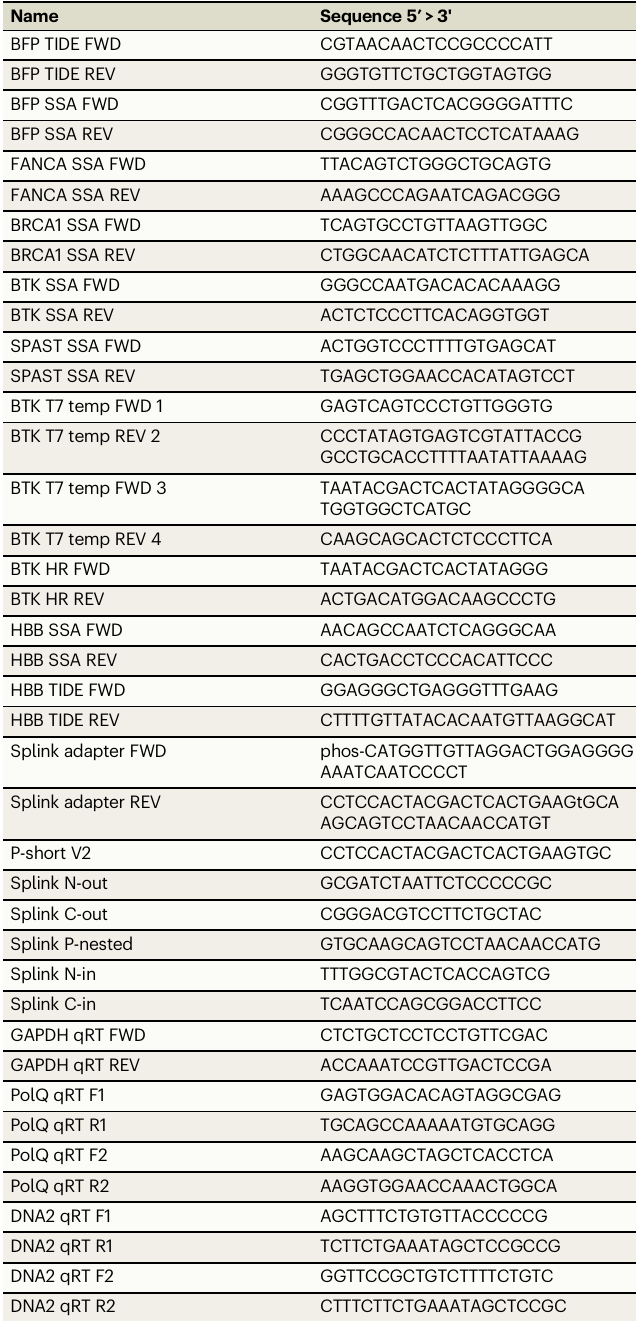
Table 1. Data were analyzed using BioRad CFX Manager Software ver- sion 3.1. Primer ef fi ciency was determined to be close to 100%. Nor- malized transcript levels were determined using the ΔΔ Ct